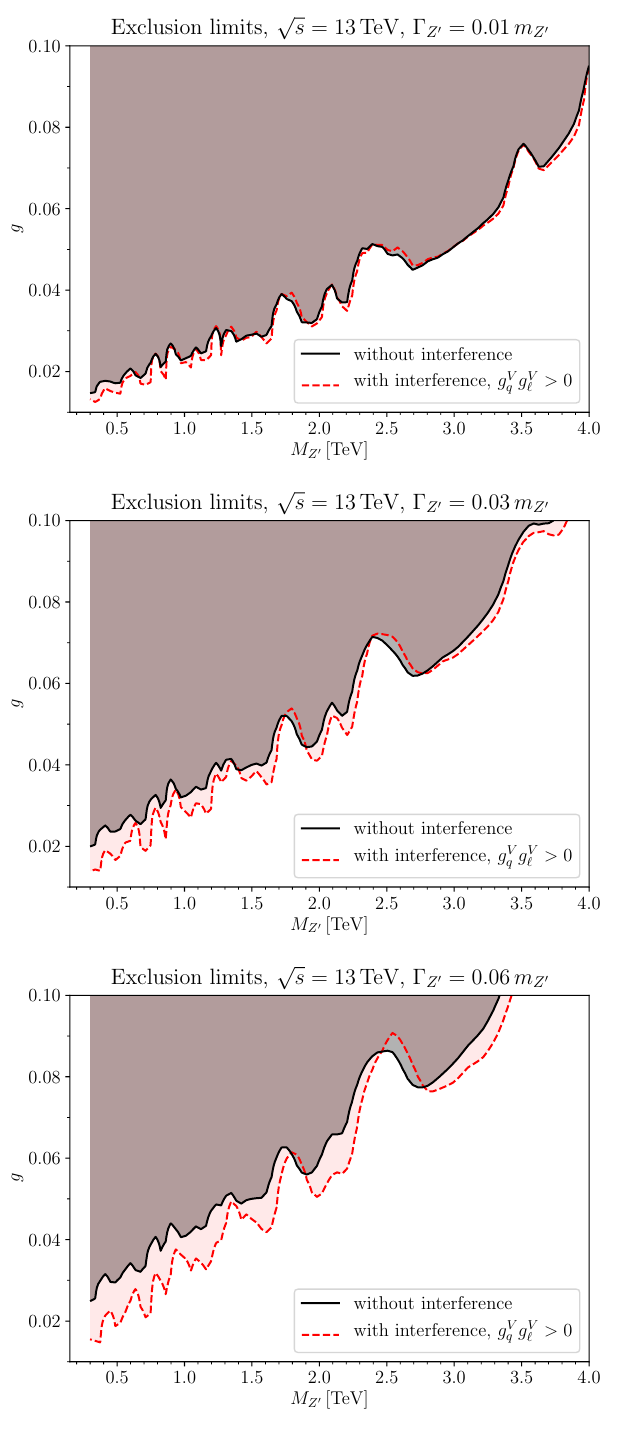
Figure 4 . Upper bound on the e(cid:11)ective coupling g = ( g V without interference e(cid:11)ects. We consider Z 0 bosons with vanishing axial couplings and di(cid:11)erent relative widths (cid:0) Z =m Z = 1%, 3%, 6%. 0 0